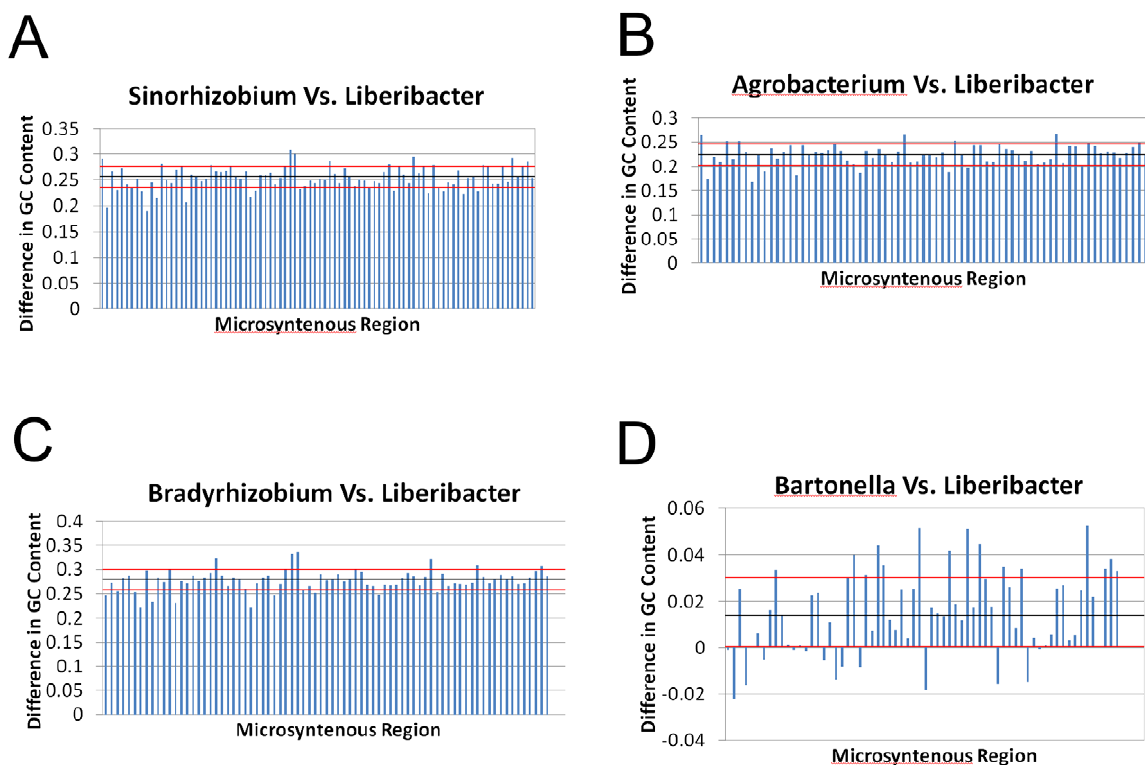
Figure 3. Differences in GC content in microsyntenous orthologous groups. The GC content of microsyntenous orthologous groups of ‘ Ca . Liberibacter asiaticus’ compared with other members of the Rhizobiales. The dark bar and red lines denote the mean and one standard deviation of the mean.